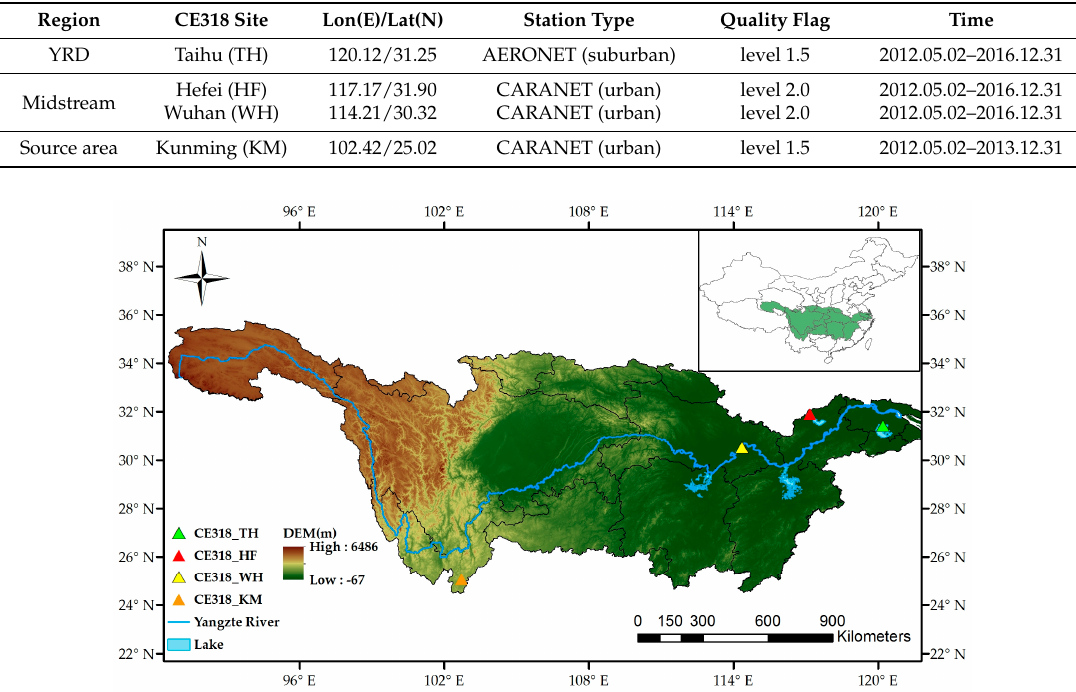
Table 2. Statistics of CE318 ground sites over YRB from 2012 to 2016 used in this study.